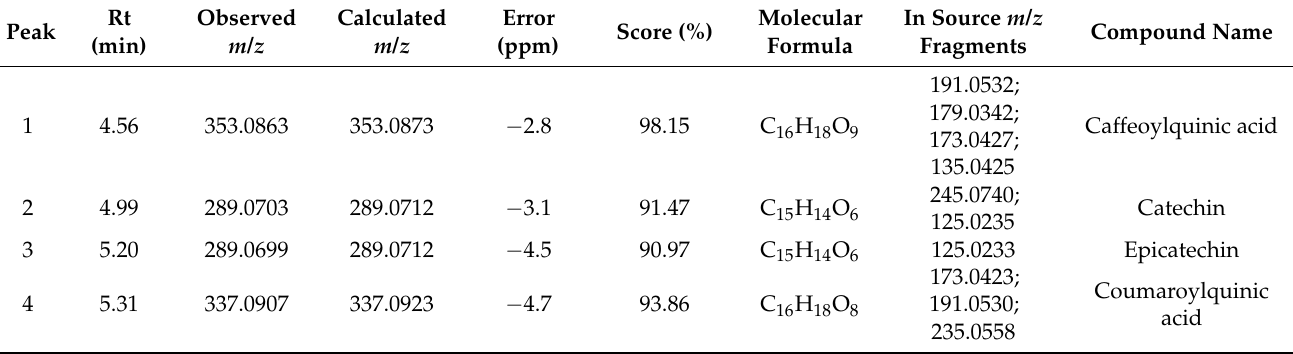
Table 1. Compounds identified by HPLC–ESI–TOF–MS in apple pomace without seed